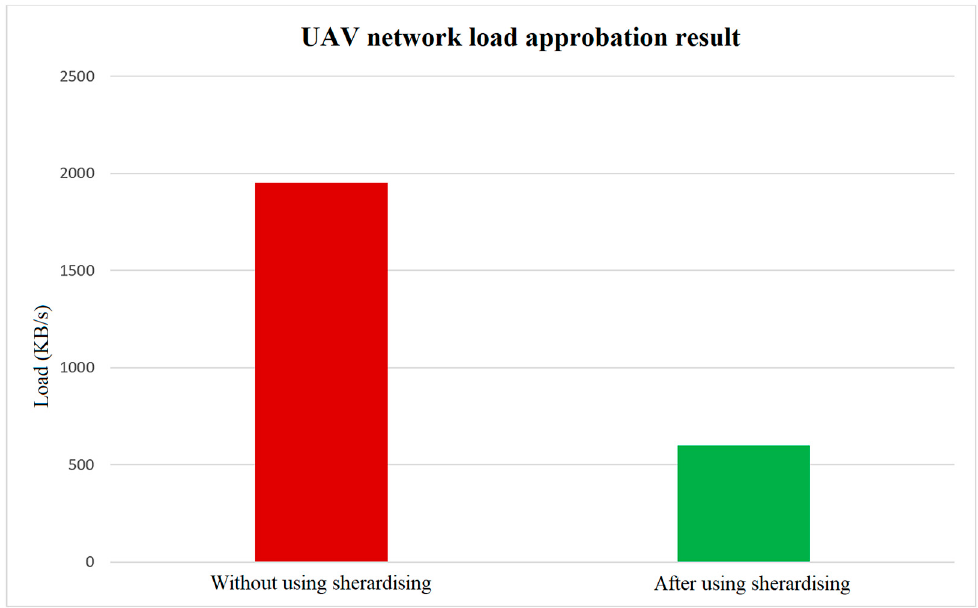
Figure 9. Result of approbation of the proposed measures.